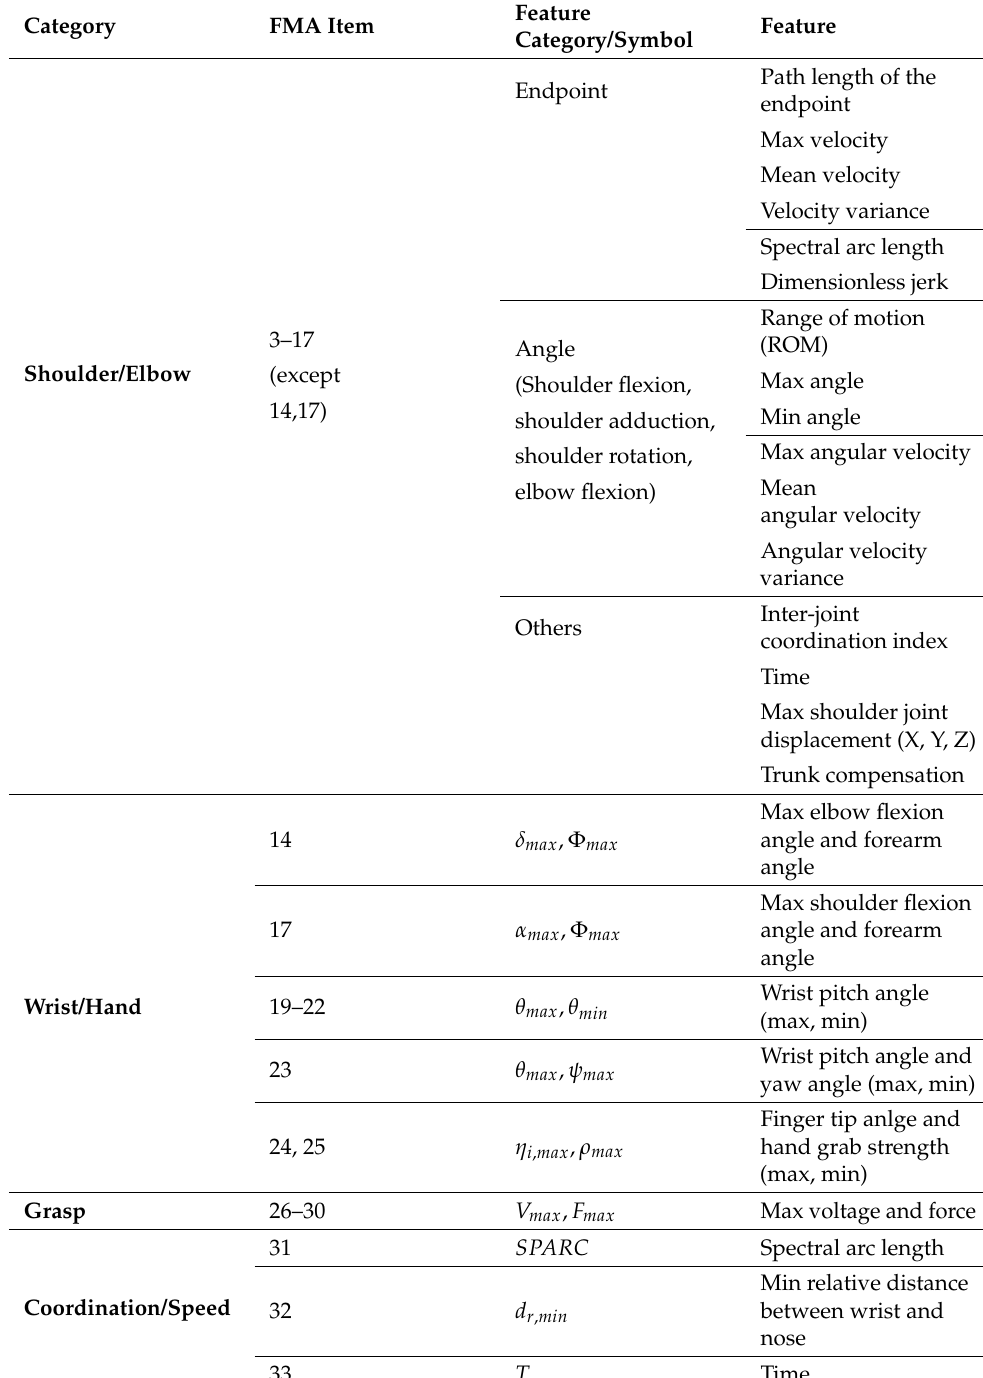
Table 3. Extracted Features for Each FMA Test